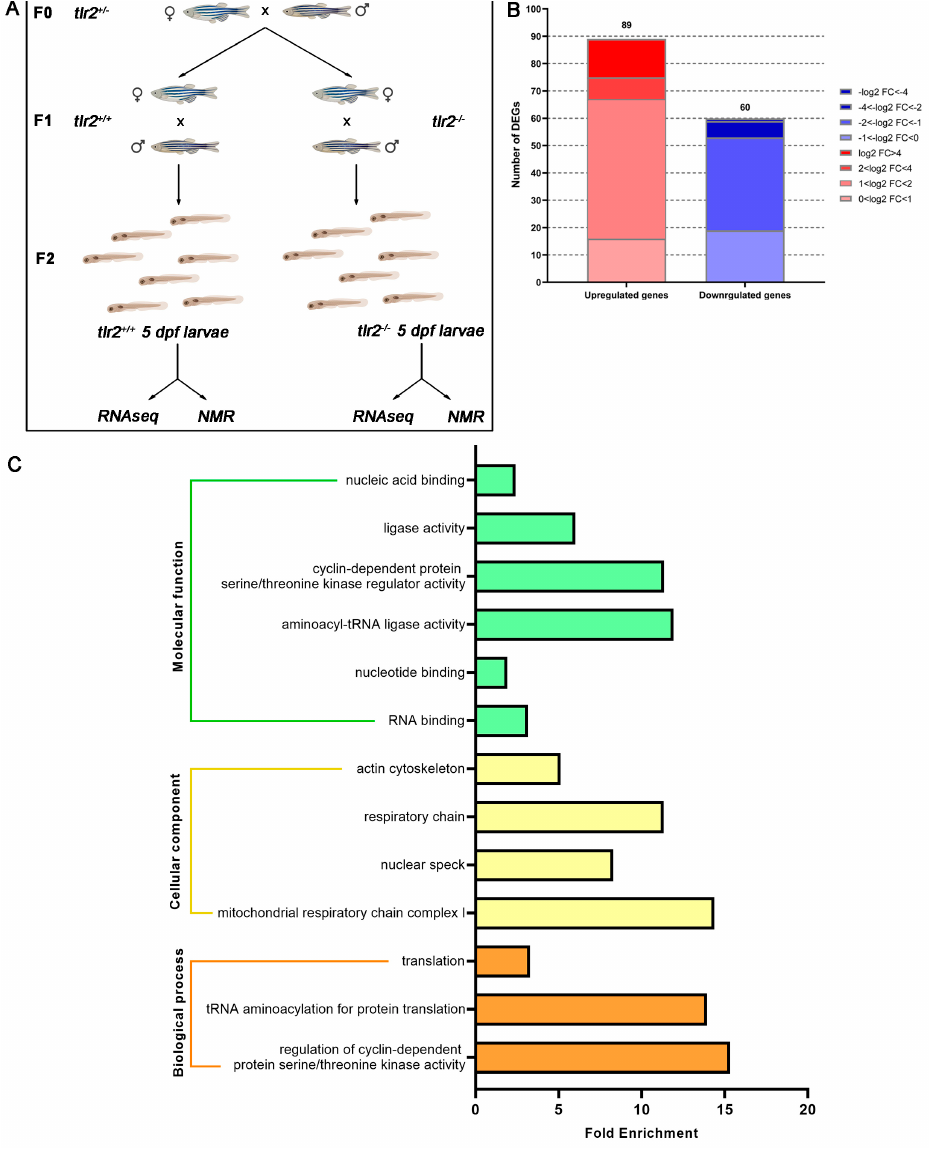
Figure 1. Experimental setup scheme and overview of the RNAseq in tlr2 mutant zebrafish larvae. ( A ) Setup of the RNAseq and 1 H NMR experiment. ( B ) Overview of the distribution of differentially expressed genes (DEGs) log2 fold change in tlr2 − / − versus tlr2 +/+ zebrafish larvae. DEGs were assessed by S value ≤ 0.005. Upregulated gene sets are shown in red, and downregulated gene sets are shown in blue. The intensity of color represents the log2 fold change level. ( C ) Gene ontology (GO) analysis. Significantly enriched GO terms for DEGs of tlr2 − / − versus tlr2 +/+ groups were determined by using the hypergeometric test/Fisher’s exact test, with a threshold of p value < 0.05 which were adjusted using the Benjamini and Hochbery FDR correction. Genes were categorized according to specific molecular functions, cellular components, and biological processes.